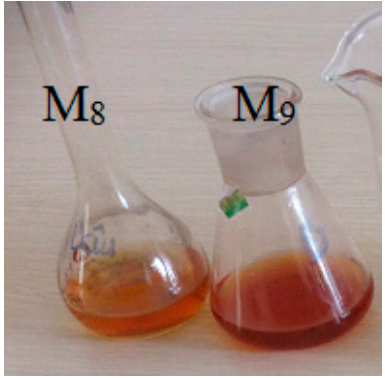
Figure 4. Photograph of silver nanoparticles (AgNPs) (M 8 ) and of AgNPsmw (M 9 ).